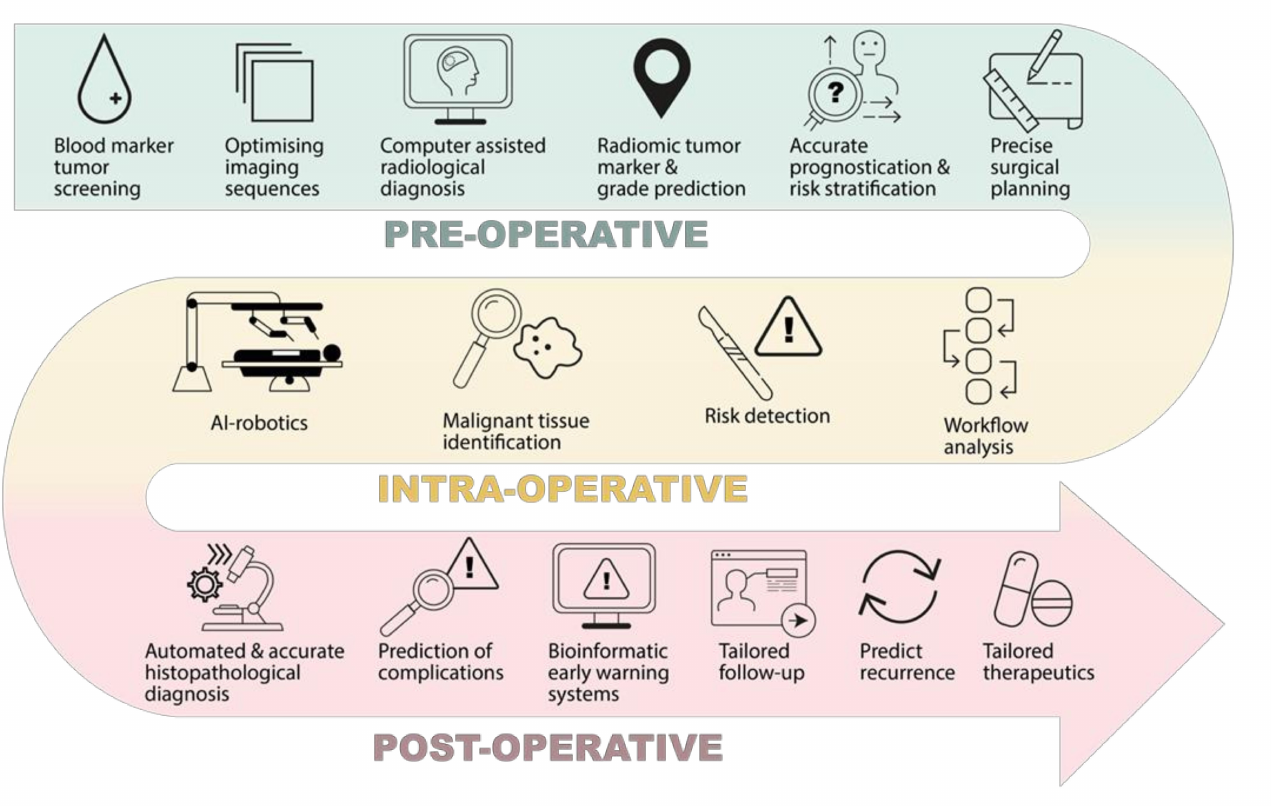
Figure 2. Potential clinical impacts of AI in the neurosurgical management of brain tumours, in the pre-operative, intra- operative, and post-operative